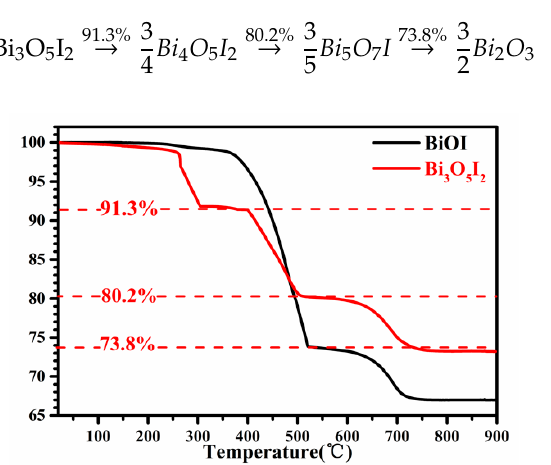
Figure 2. Thermogravimetric (TG) profiles of Bi 3 O 5 I 2 and bismuth oxyiodide (BiOI) samples in air flow.